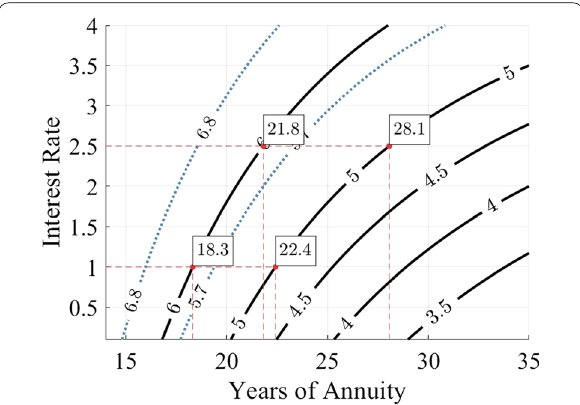
Fig. 3 Examplary conversion rates. Figure shows for different conversion factors (iso-curves), and interest rates (y-axis) how long pension payments last until a retired insurants own savings are depleted (x-axis). Pension payments assumed as annuities, with constant interest rates and annual pension payments in the amount of the respective conversion rate as a percentage of a retired insurants savings at the time of retirement. Source: Own